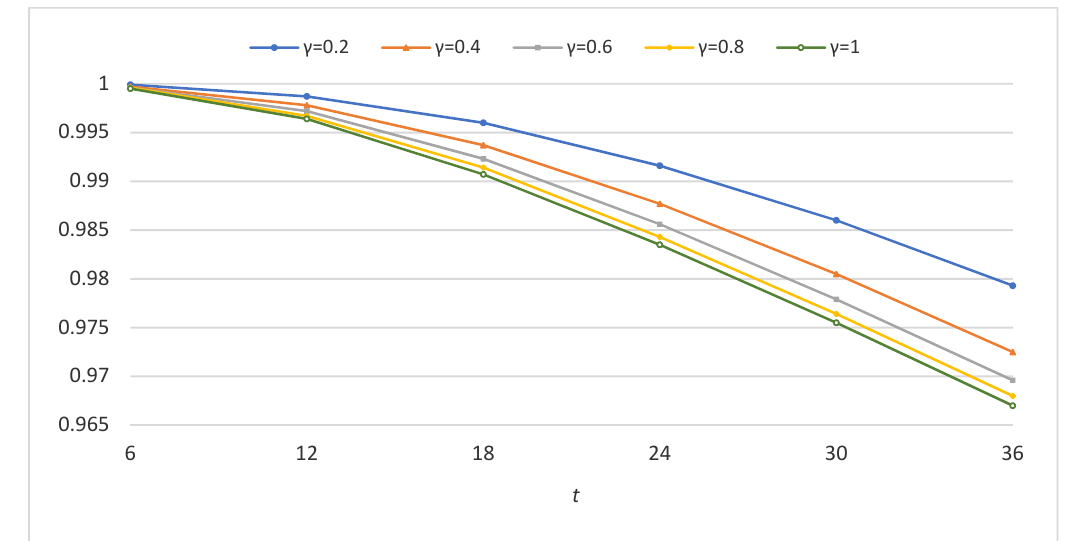
Figure 6. Bitcoin dependability before and after the application of the ALP.